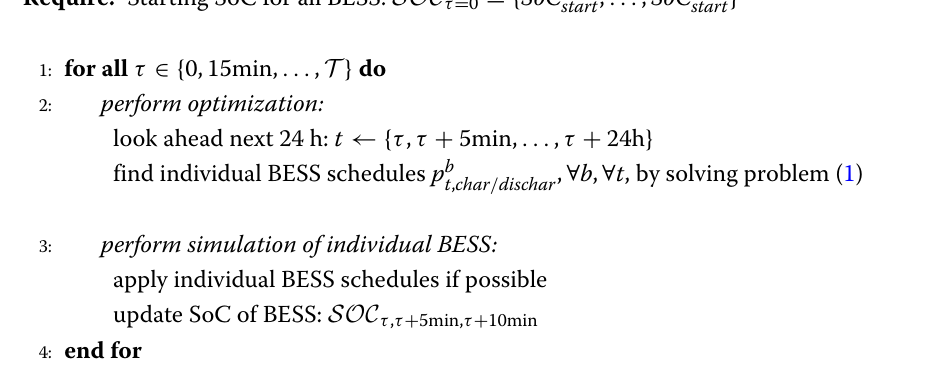
Algorithm 2 Procedure of co-simulation framework: based on global optimization (1) Require: Starting SoC for all BESS: SOC τ = 0 = { SoC 1